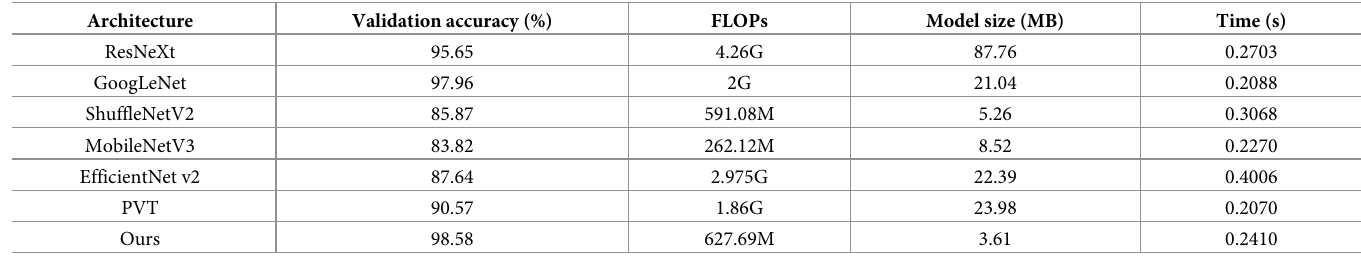
Table 3. Performance analysis results of different